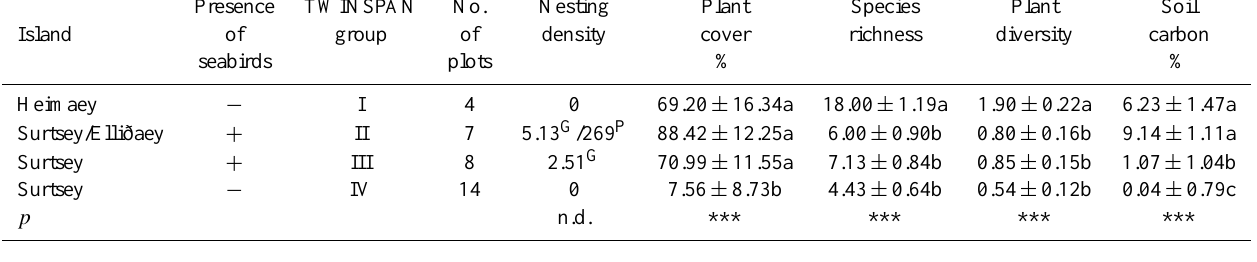
Table 3. Average density of seabird nests (no. /1000m 2 ) , plant cover, species richness and diversity of vascular plants, and soil carbon in plots sampled on islands, according to main TWINSPAN groupings; G : average density of gull nests on Surtsey 2003–2013; P : average density of puffin nests on Elliðaey in 2013. Means ± s.e.; p = ANOVA level of significance, n.s. = >0.05; * =≤ 0.05: ** =≤ 0.01; *** =≤ 0.001. Means with same letter are not significantly different at p = 0 . 05.